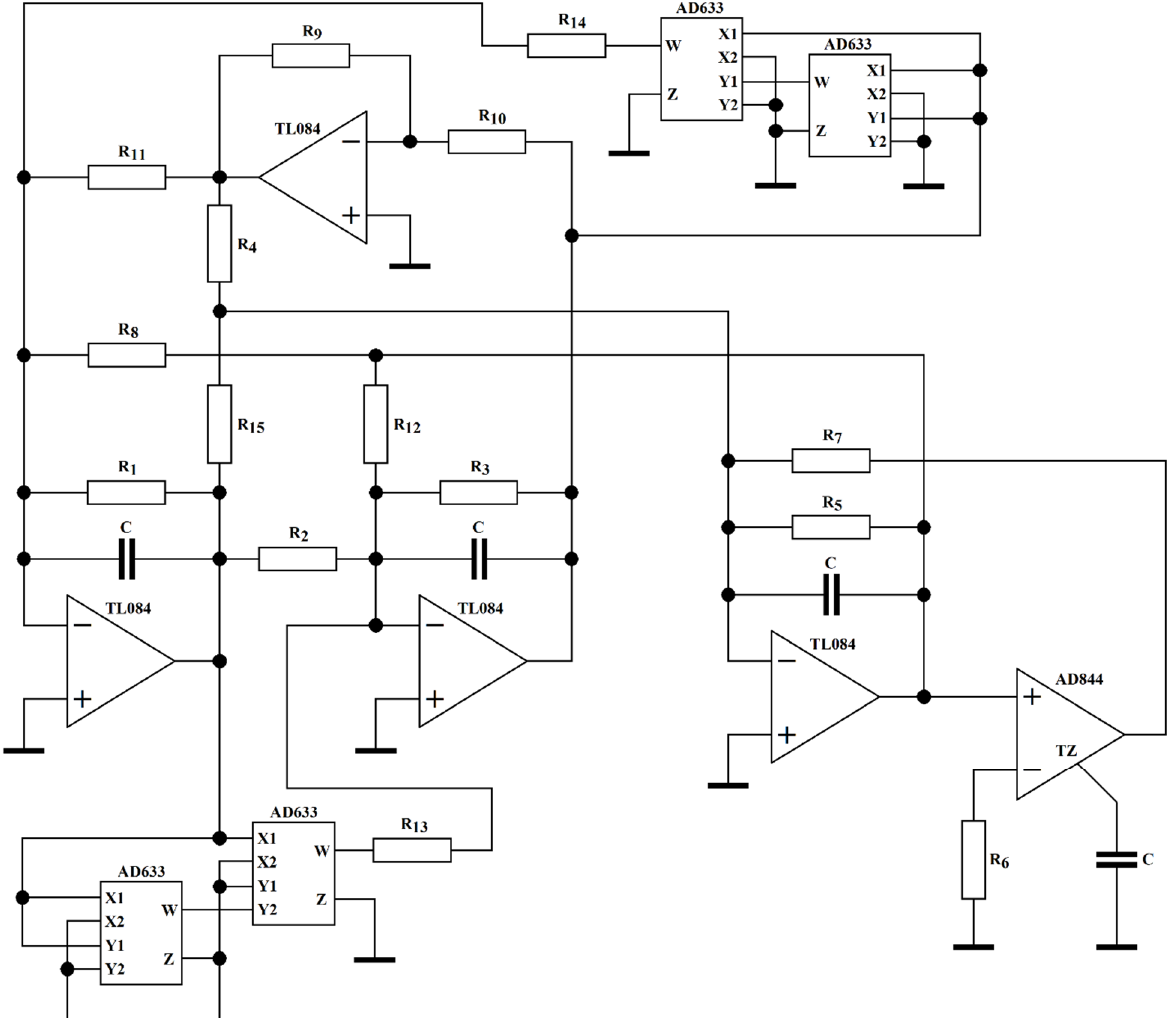
Figure 16. Fourth order fully analog chaotic oscillator constructed by using only commercially available active elements, namely single TL084, one AD844 and four AD633.